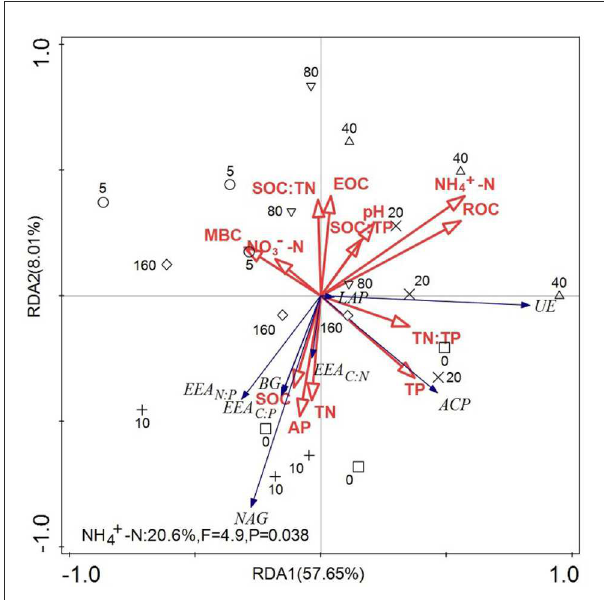
FIGURE5 Redundant analysis diagram of the influence of soil nutrients on soil enzyme activity and stoichiometric ratios. Soil enzyme activity and the ecological enzyme stoichiometric ratio were used as response variables, and soil environmental factors were used as explanatory variables for redundancy analysis (RDA). The arrows connecting soil microbial enzyme activities and enzyme stoichiometric ratios are in blue, and the arrows connecting the soil environmental factors are in